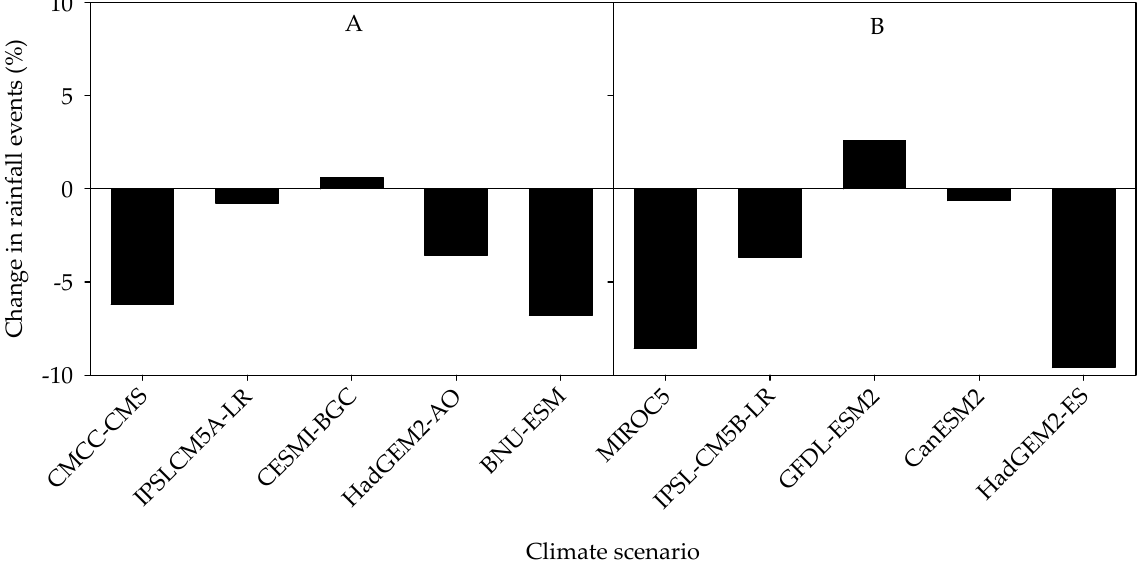
farms ranged from 1919 kg/ha to 2019 kg/ha. Under elevated CO 2 concentrations, yield increased to between 2416 and 2528 kg/ha. The variability in grain yields among farms under RCP 4.5 was between 18% and 23% and 16% and 21% with and without elevated CO 2 concentrations, respectively. In both cases, the hot wet scenario yielded the highest variability and lowest mean grain yields. Under RCP 8.5, simulated grain yields assuming ambient CO 2 resulted in yield declines as with RCP 4.5; thus, the distribution of yields under all GCMs were to the left (towards lower grain yields) of that of the baseline yields (Figure 9). As with RCP 4.5, the hot wet climate scenarios yielded the lowest mean grain yield among the climate scenarios irrespective of CO 2 concentration used, while the middle scenarios exhibited the highest grain yield. Simulated grain yields were between 1842 and 2011 kg/ha under ambient CO 2 concentrations and between 2497 and 2717 kg/ha under elevated CO 2 concentrations. Var- iability in grain yields was generally higher under ambient CO 2 conditions (17–26%) than under elevated CO 2 concentrations (15–24%).